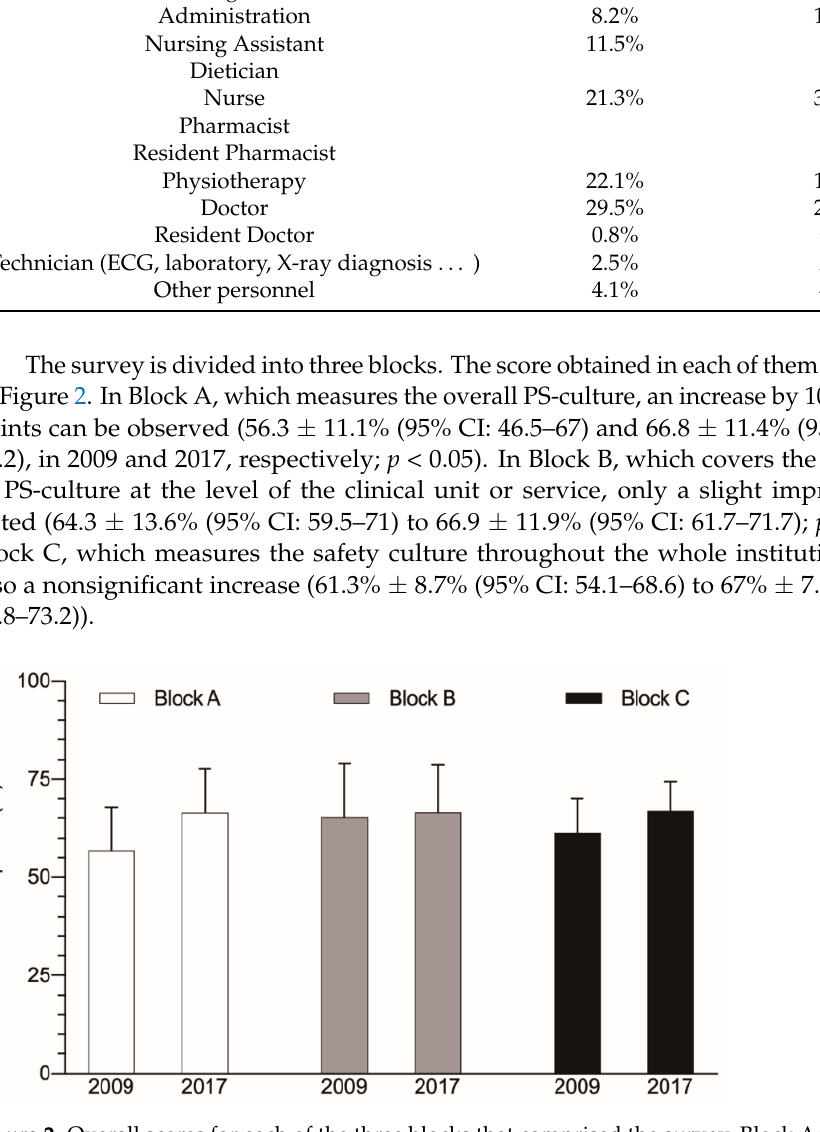
Figure 2. Overall scores for each of the three blocks that comprised the survey. Block A: results of the safety culture (white bar); Block B, aspects of the culture of safety at the unit/service level (grey bar); Block C, aspects of the culture of safety at the whole hospital level (black bar).